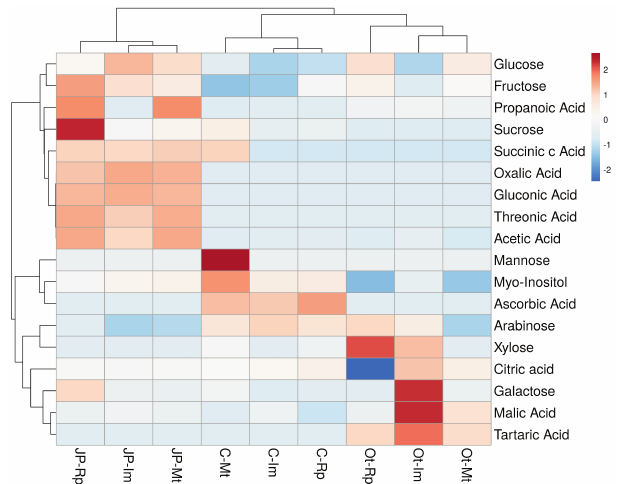
Fig. 4 ­ Heatmap of the profiled and identified metabolites in Carambola, June plum and Otaheite fruits through diffe­ rent development and ripening stages. The color scale represents the relative concentration of each metaboli­